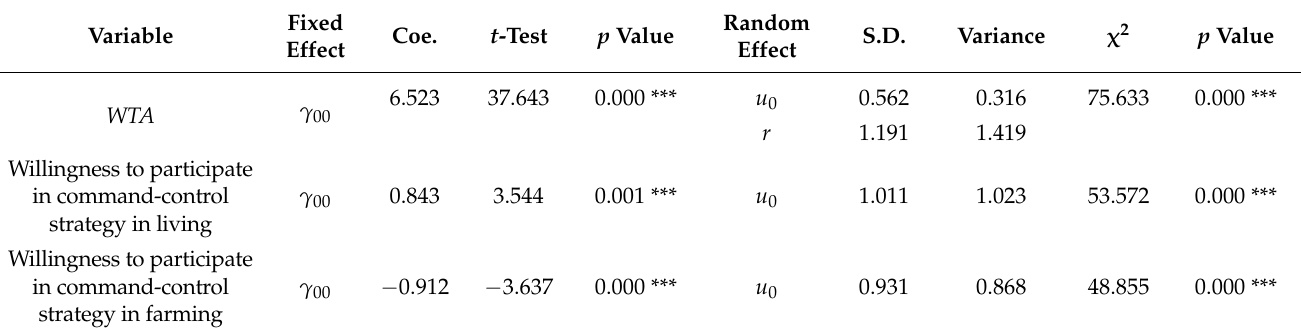
Table 3. Regression results of the null models.